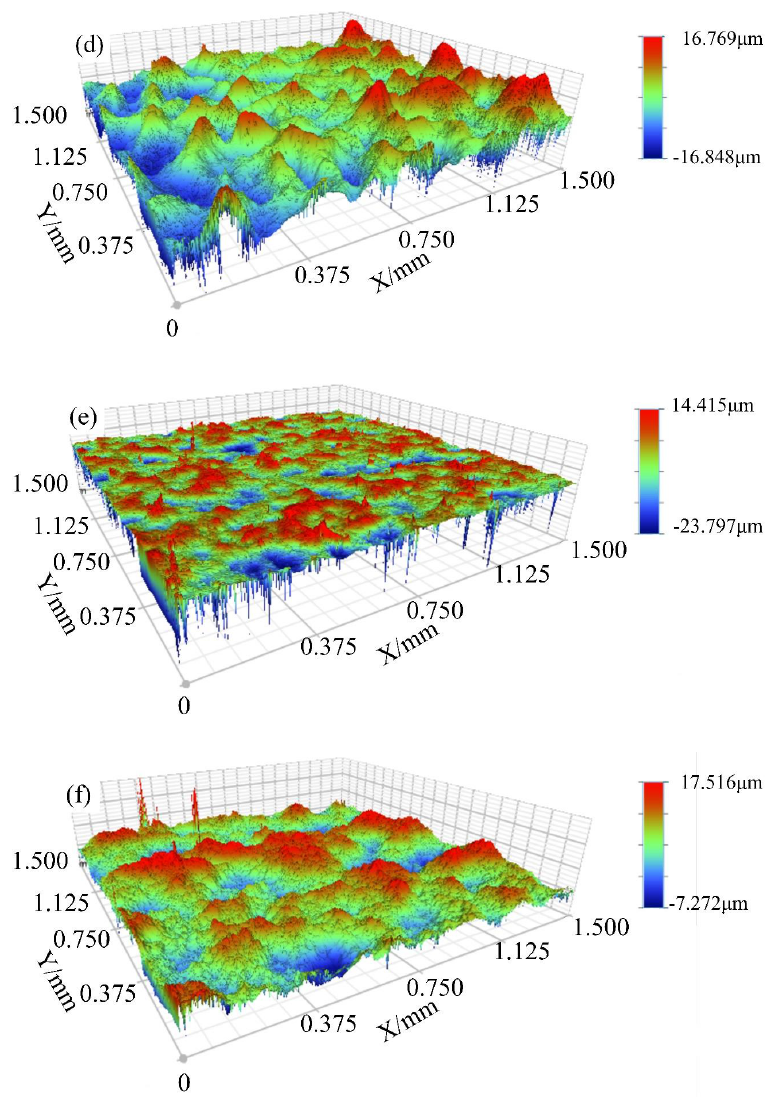
Figure 5. Surface topographies of samples before and after AWJP treatment: ( a ) Sample S0; ( b ) Sample S1; ( c ) Sample S2; ( d ) Sample S3; ( e ) Sample S4; and ( f ) Sample S5. Table 5. Values of the surface roughness parameter of all samples.